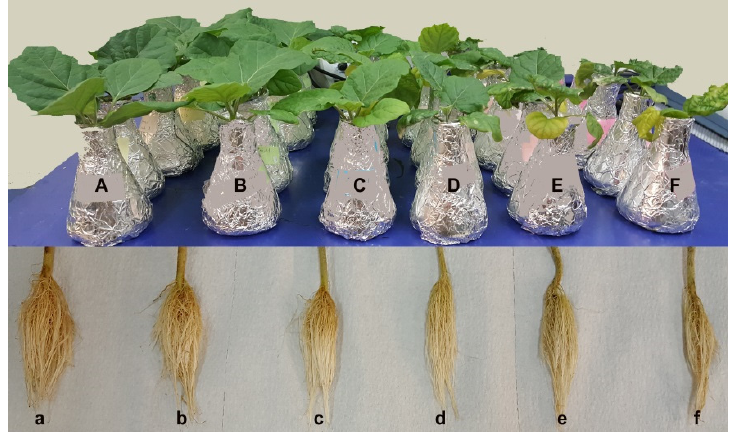
Figure 1. Effect of NaCl on Solanum melongena growth. ( A – F ) Shoot growth [from left to right; ( A ) control, 25 ( B ), 50 ( C ), 75 ( D ), 100 ( E ), and 150 ( F ) mM NaCl]. ( a – f ) Root growth [from left to right; ( a ) control, 25 ( b ), 50 ( c ), 75 ( d ), 100 ( e ), and 150 ( f ) mM NaCl].